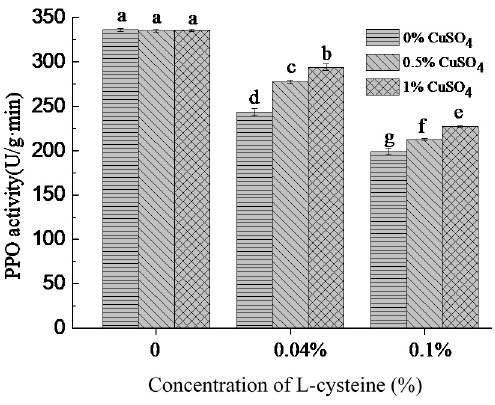
Figure 2. Effect of copper acetate on PPO activity of PPO solutions mixed with L-cysteine. Different lowercase letters show significant differences ( p < 0.05).